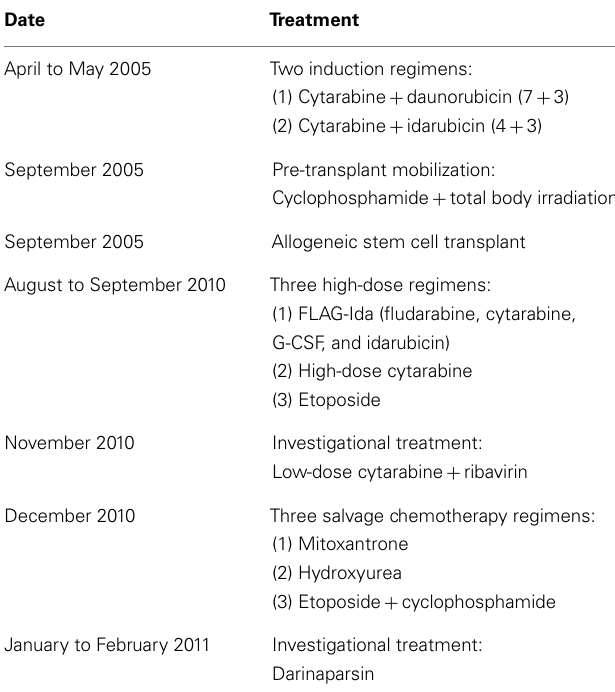
Table 1 | List of regimens used to treat the